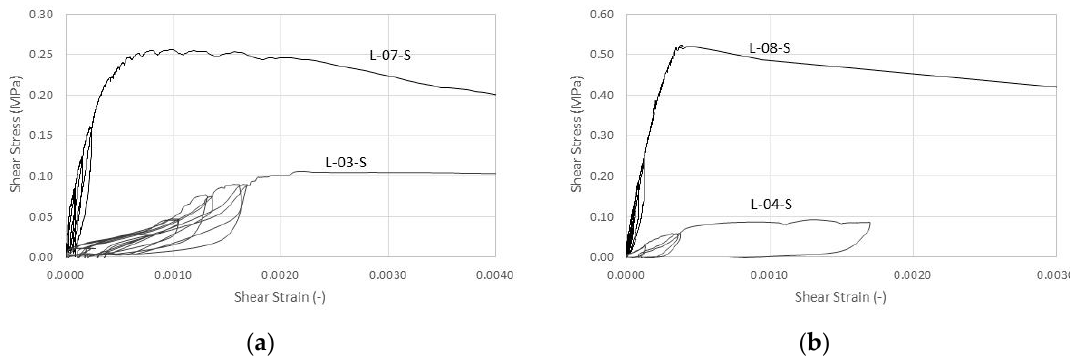
Figure 8. Shear tests carried out on panels cut off from Building No. 1 (non-rendered panels) and 2 (rendered panels): ( a ) Stone work panels; ( b ) Brickwork panels. Table 4. Results of shear tests.